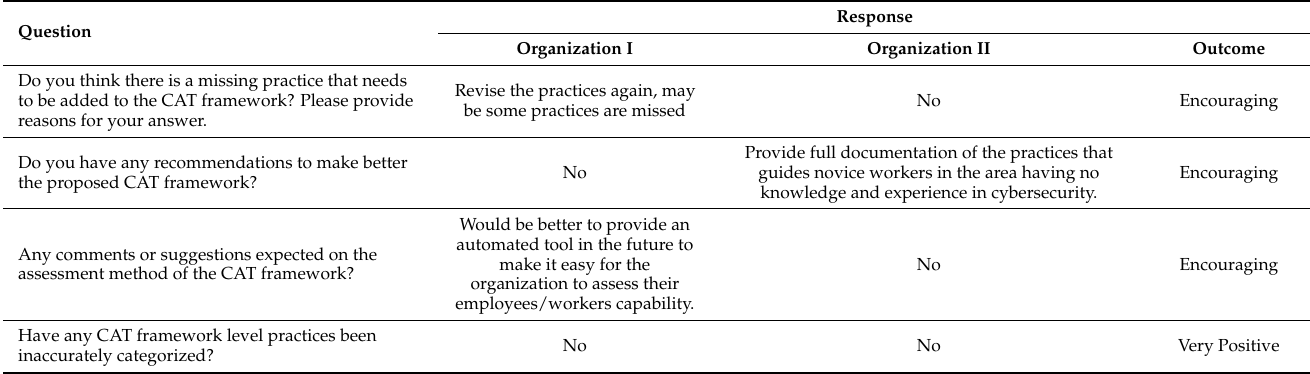
Table 6. CAT framework post-case-study responses from both organization I and organization